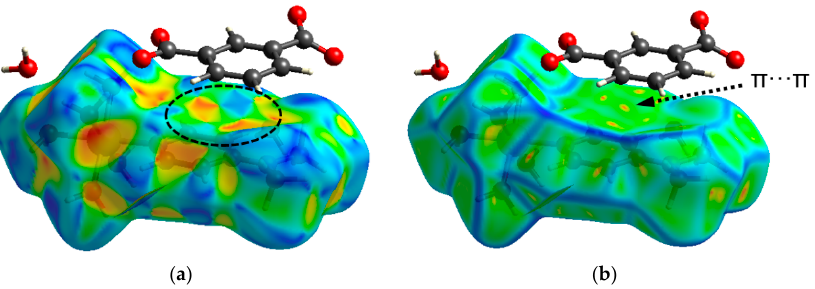
Figure 10. Full two-dimensional fingerprint plots for compounds 1 (left) and 2 (right) showing the spikes corresponding to the main intermolecular interactions. The percentage relative contributions of the intermolecular contacts to the total HS area are discussed in the main text. The FP plots show (1) H···O/O···H, (2) H···C/C···H and (3) H···Cl/Cl···H contacts.